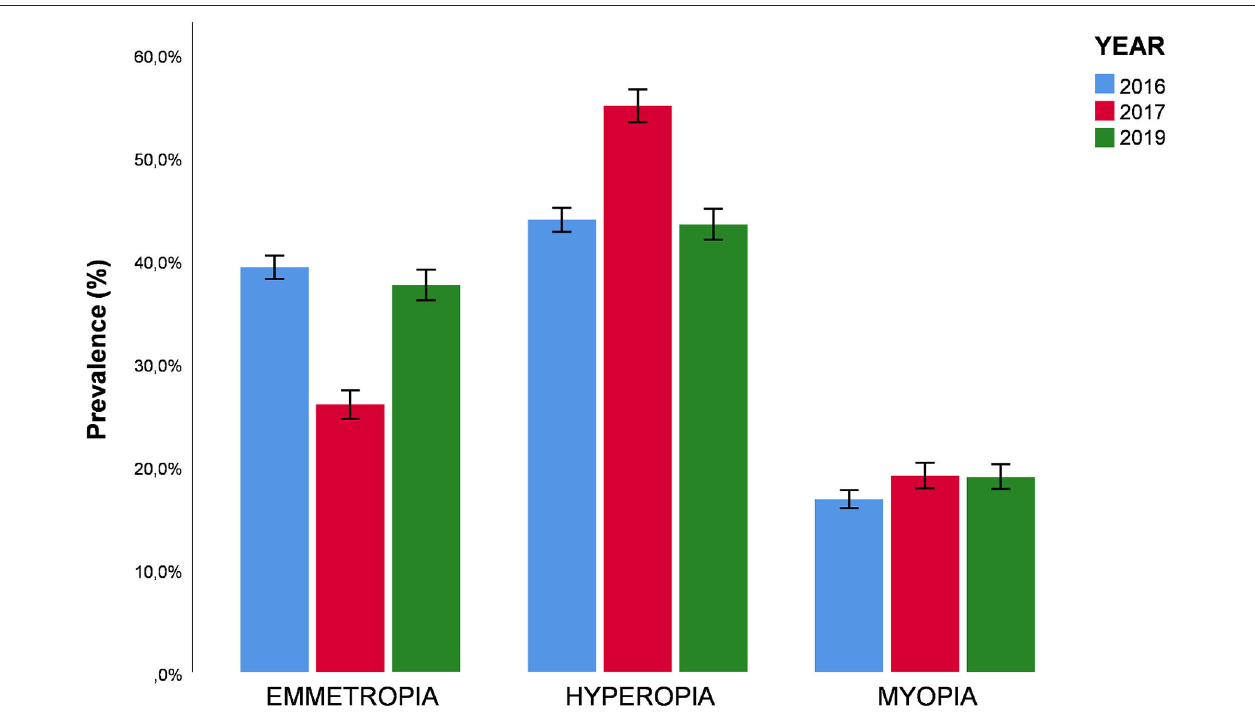
FIGURE 1 | Prevalence of ametropies in 2016, 2017, and 2019.